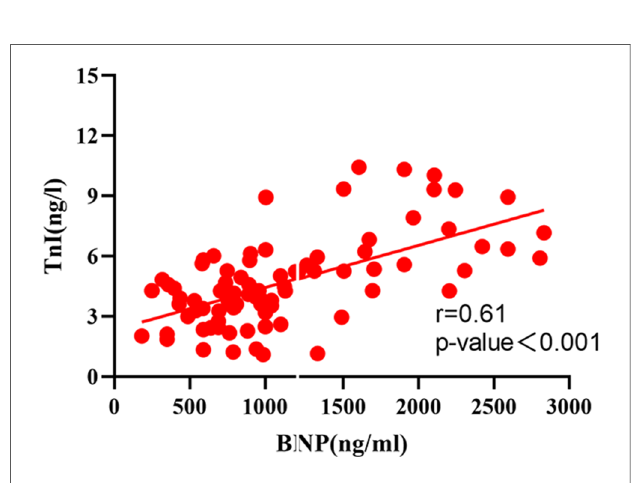
FIGURE 5 Correlation between serum BNP and DFR after